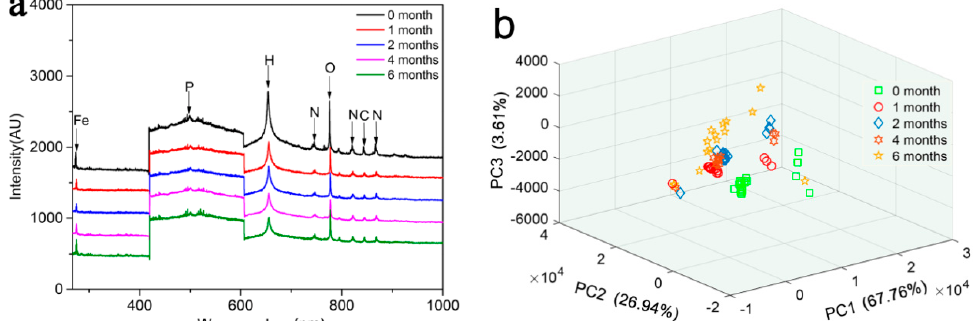
Figure 3. Average LIBS spectra of MOF and the principal component analysis (PCA) distributions based on the LIBS of the MOF with different treatments. ( a ). Spectra of MOF degraded in wheat farm soil for zero months, one month, two months, four months, and six months. ( b ). The first three PCA scatterplots based on the LIBS of MOF.